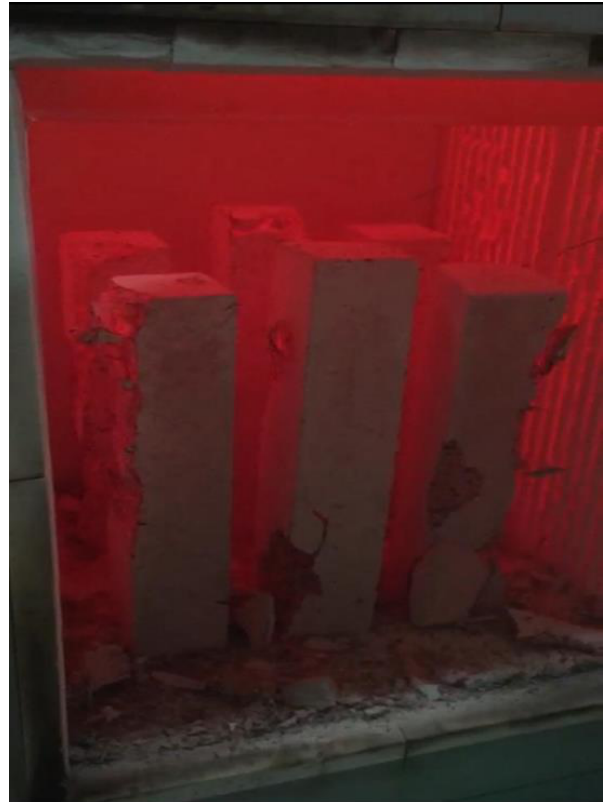
Figure 11. Samples that spalled inside the oven.